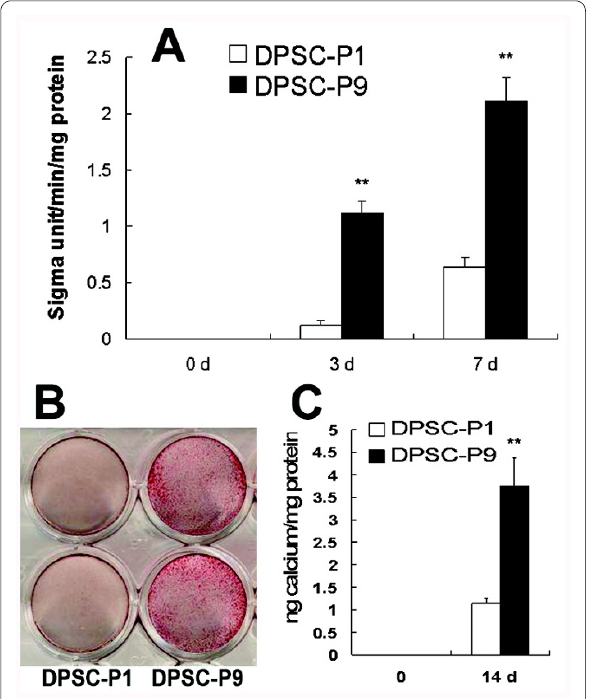
Figure 4 ALP assay and alizarin red staining of DPSCs in the min- eralization-inducing media . ( A ) ALP concentrations in DPSCs at dif- ferent passages. DPSC-P9 group presented a higher ALP level ( P < 0.001) than DPSC-P1 group after 3 d or 7 d induction. ( B ) Alizarin